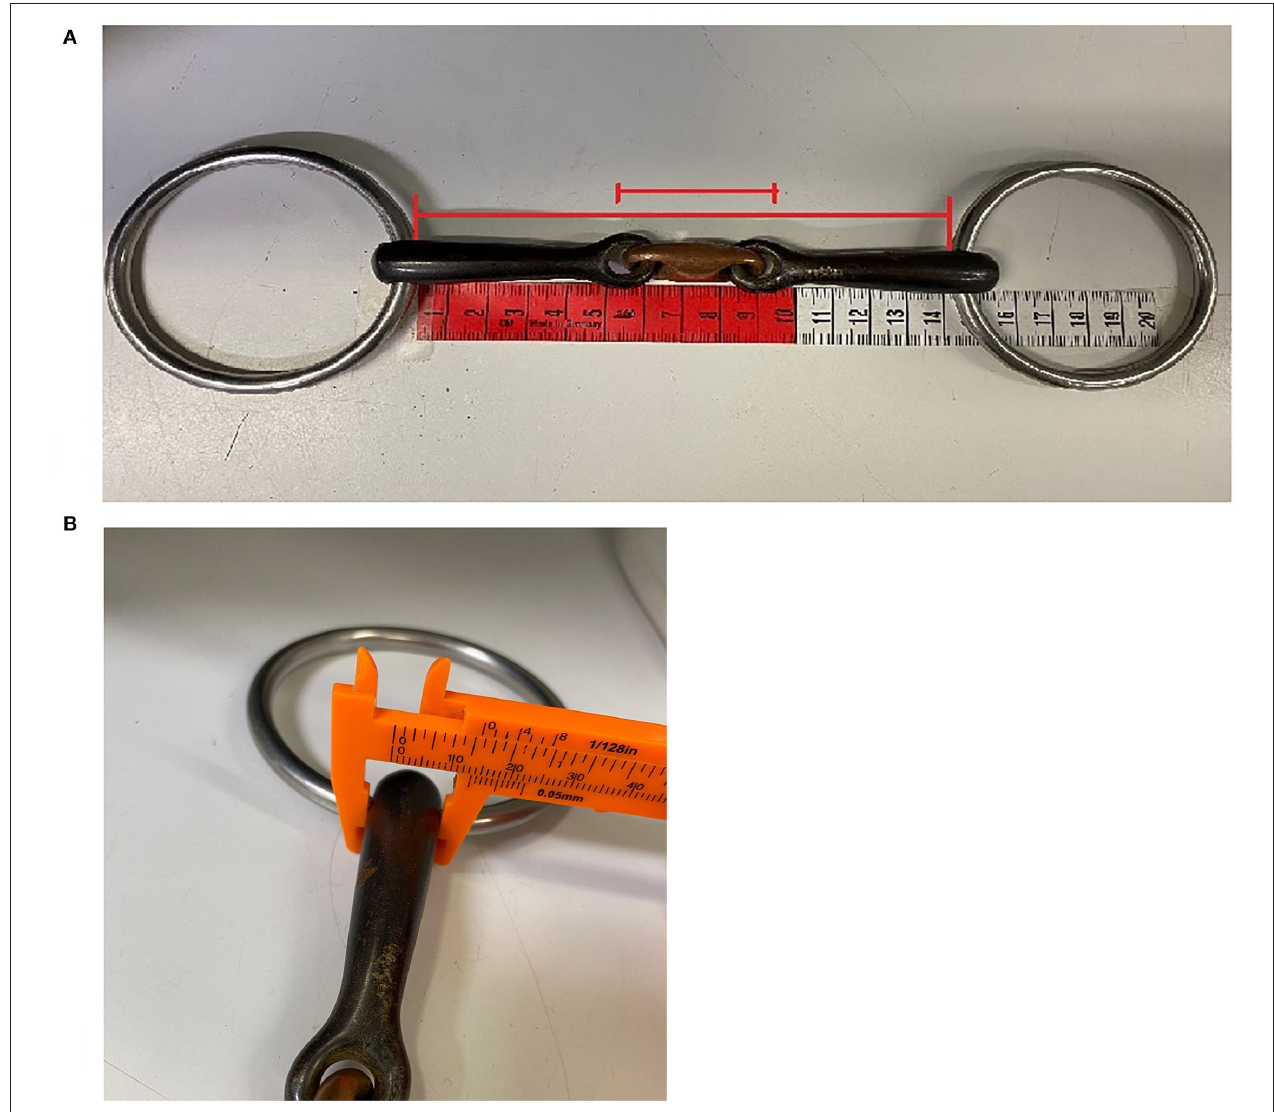
FIGURE 2 | Bit size measurements: (A) bit mouthpiece and center link length, (B) bit mouthpiece thickness.